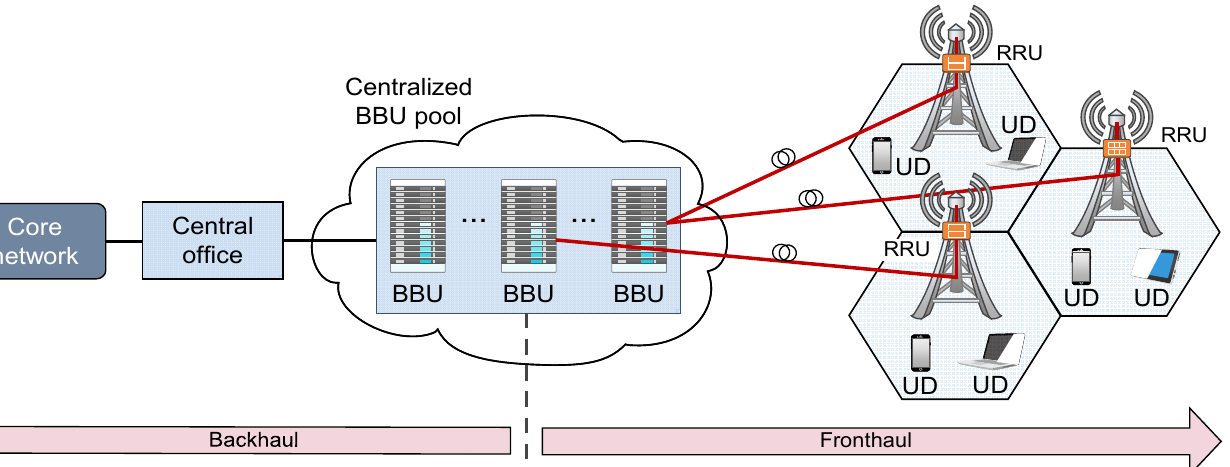
Figure 9. C-RAN architecture.